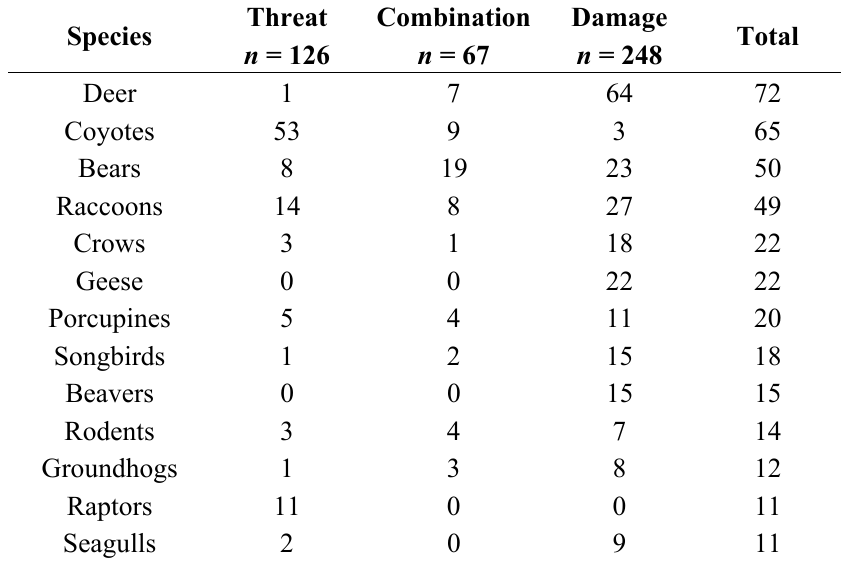
Table 5. Species listed at least 10 times, categorized by threat, damage, or both.